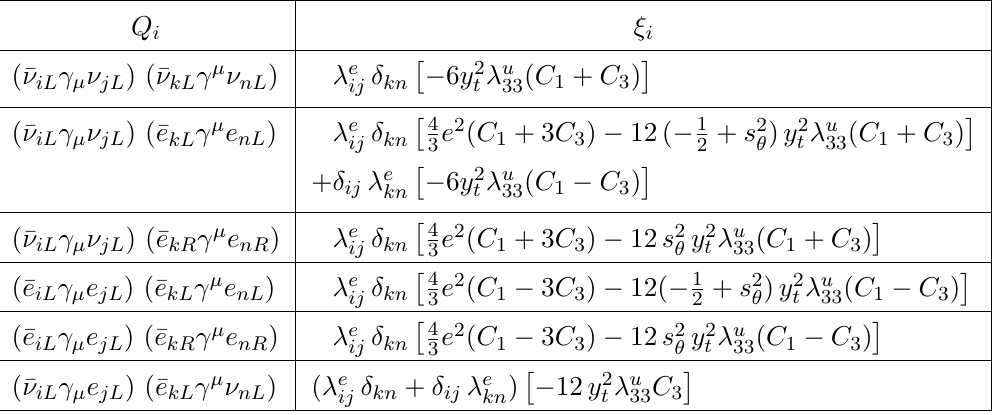
Table 2 . Operators Q i and coe(cid:14)cients (cid:24) i for the purely leptonic part of the e(cid:11)ective Lagrangian L EW . We set sin 2 (cid:18) W (cid:17) s 2 e(cid:11) At a scale (cid:22) just below m we end up with our (cid:12)nal result for the Wilson coe(cid:14)cient of ((cid:22) e